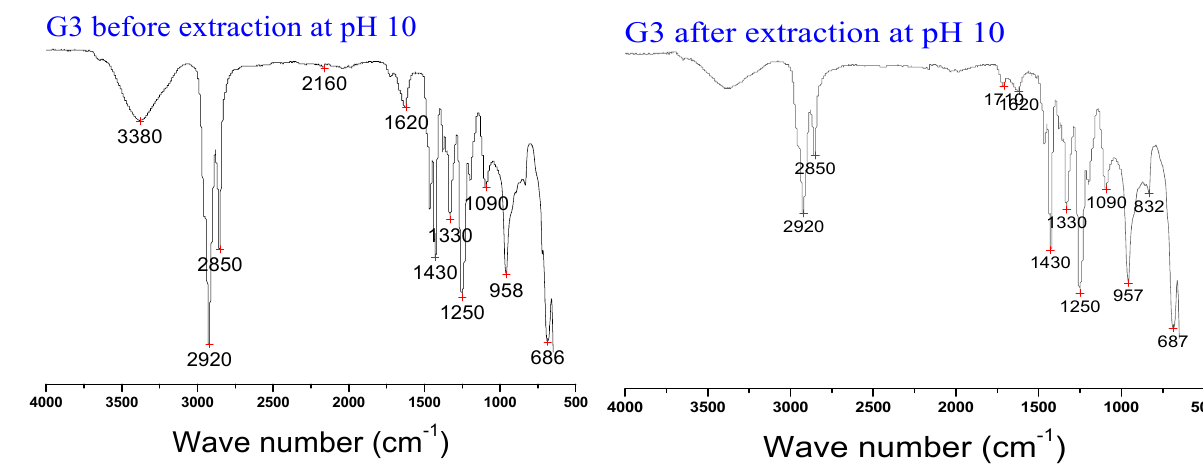
Figure 4. Compared FTIR spectra of G3 before and after Ibuprofen extraction.